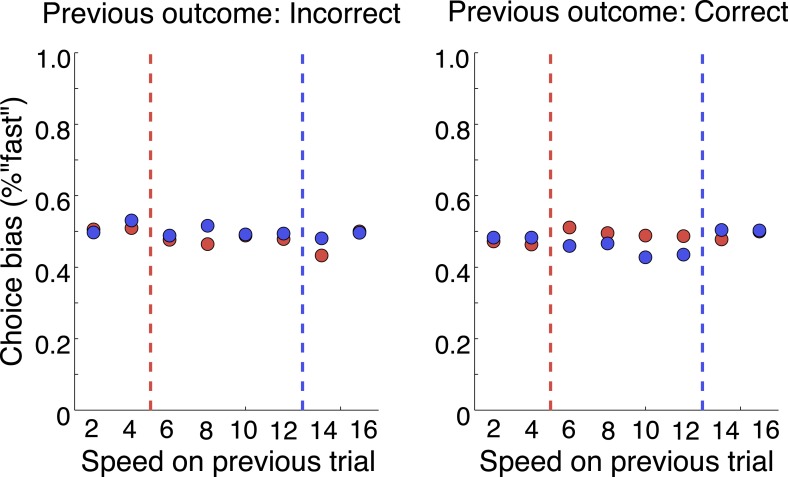
No effect of previous trial on current choice.